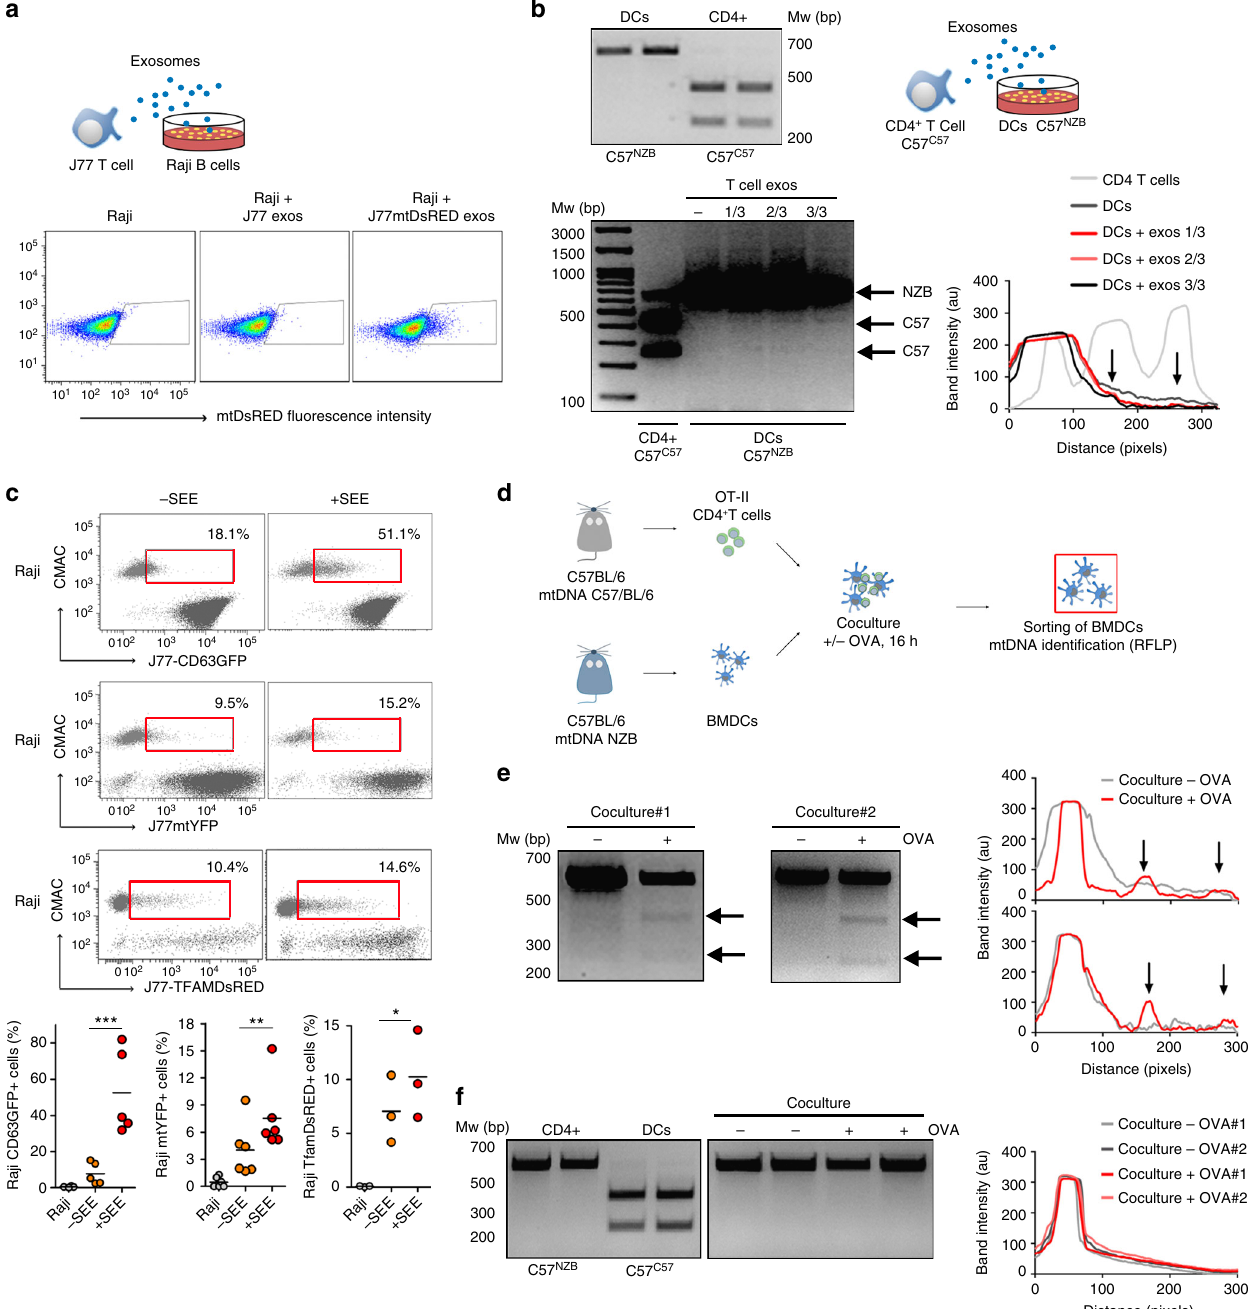
Fig. 4 Transfer of mitochondrial components during immune cognate interactions. a Flow cytometry analysis of Raji B cells incubated overnight with exosomes from J77 T cells control or stably expressing mitoDsRed (Representative experiment, n = 3). b Up: RFLP analysis of the mitochondrial genomes of C57 C57